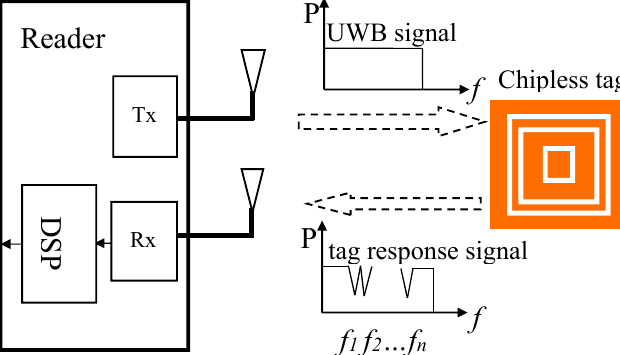
Figure 1. Working principle of RFID system, in which UWB signal is transmitted by the reader. The tag receives the signal and submits its reaction in resonant way. The reader receives the encoded signal.